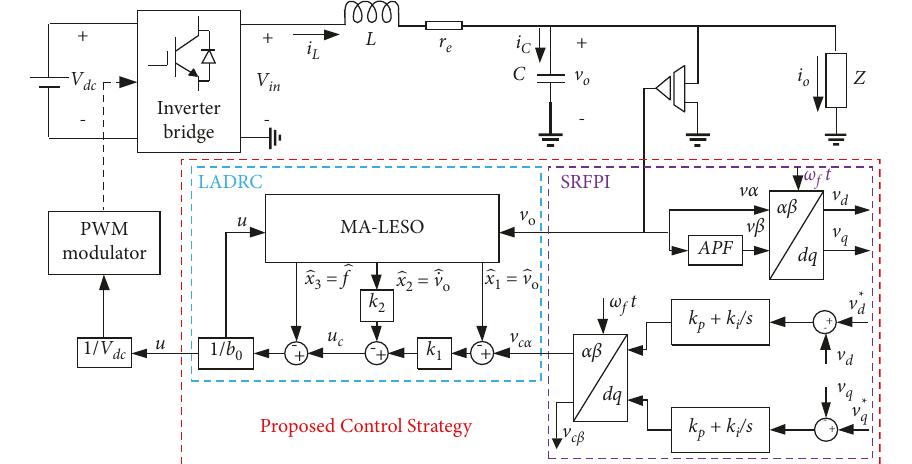
/ δ u and (b) 􏽢 x / δ y . 1 1